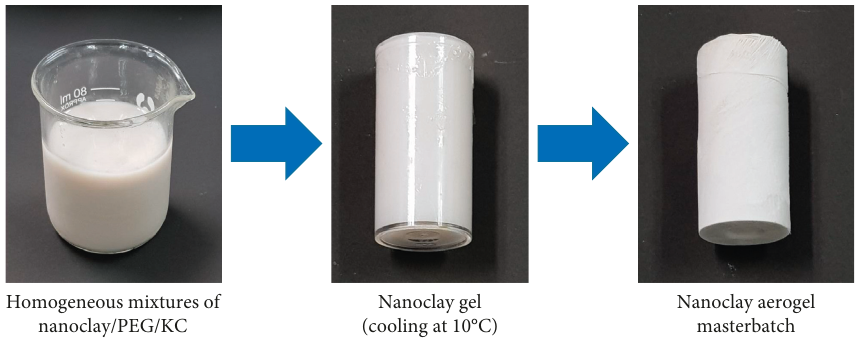
Figure 3: The illustration steps of nanoclay aerogel masterbatch preparation.